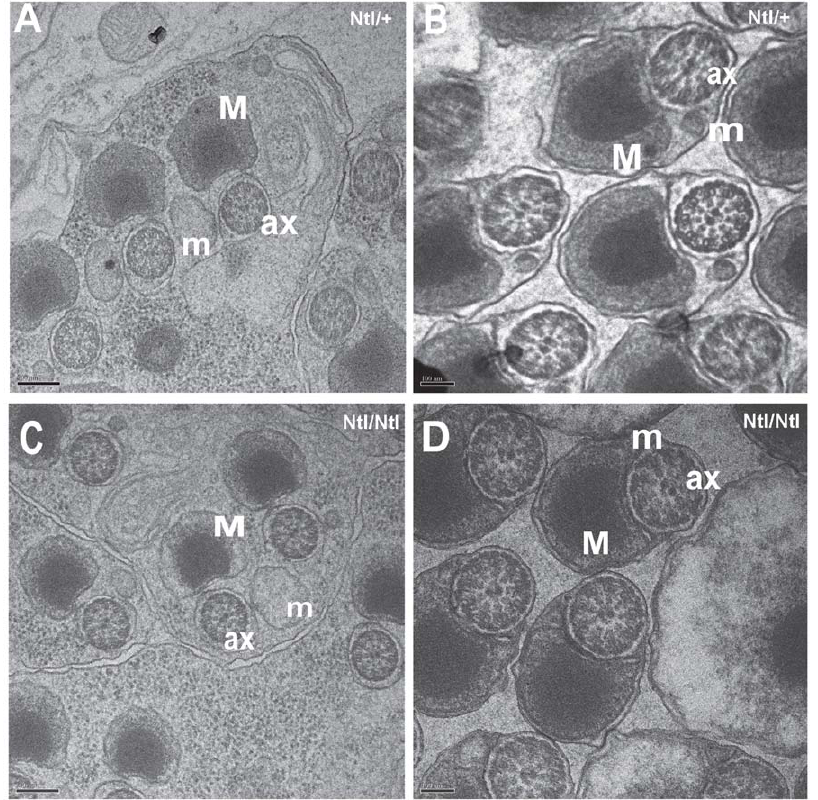
Figure 6. Ultrastructure of Ntl mutant spermiogenesis. A, B: TEM of cross-sections through wild-type pre-individualized and post- individualized cyst respectively. C and D: cross-sections through pre-individualized and individualized cyst of Ntl/Ntl mutant cyst. No obvious differences between the mutant and the wild type phenotype were observed at this level of resolution. ax, axoneme; M, major mitochondrial derivative; m, minor mitochondrial derivative. Bars, 200 um (A, C); 100 um (B, D).